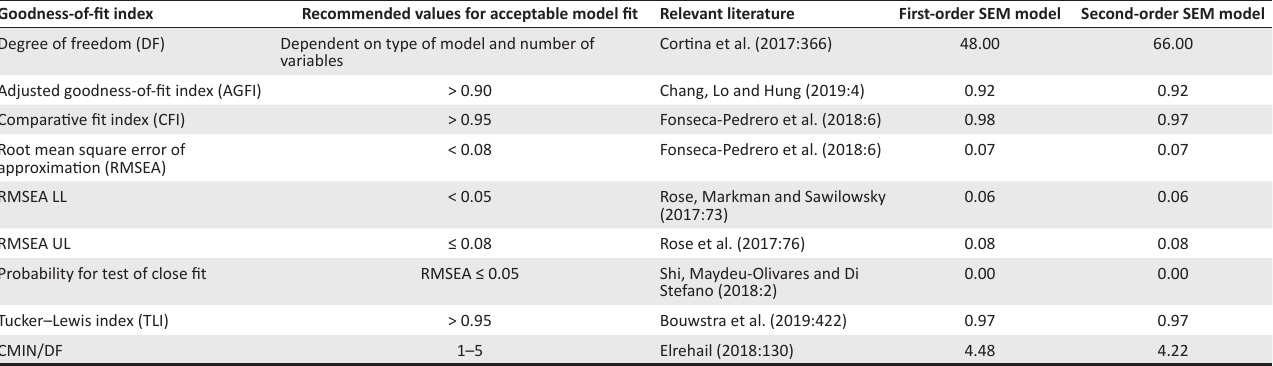
TABLE 4: Effectuation first-order and second-order model indices. Goodness-of-fit